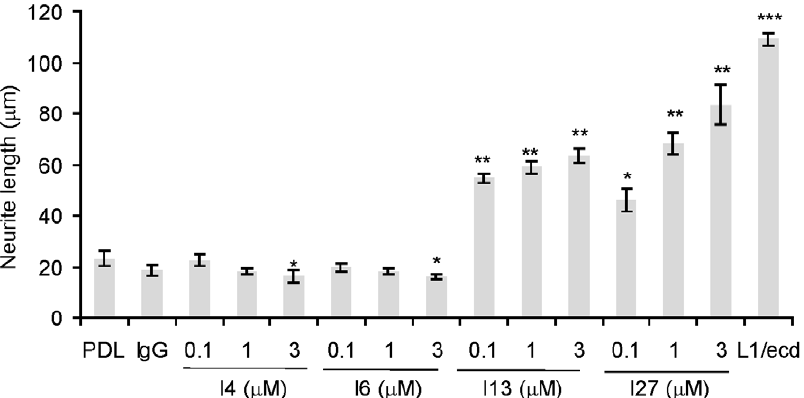
Figure 6. ScFvs against Ig1–4 inhibit, while scFvs against Fn1–3 stimulate neurite outgrowth from SK-N-SH cells. Human SK-N-SH cells were seeded into poly-D-lysine (PDL)-pretreated culture plates coated with human non-immune human IgG (10 m M), L1/ecd (3 m M), scFvs I4, I6, I13 and I27 as substrates at the indicated concentrations and cultured at 37 u C. Cultures were fixed after 5 days and stained with toluidine blue. The lengths of neurites were measured. Data represent mean values of neurite lengths per cell 6 SEM as compared with wells coated with PDL only from three independent experiments. Asterisks denote significant differences from control. *** p , 0.001, ** p , 0.01, * p , 0.05, Student’s t-test.